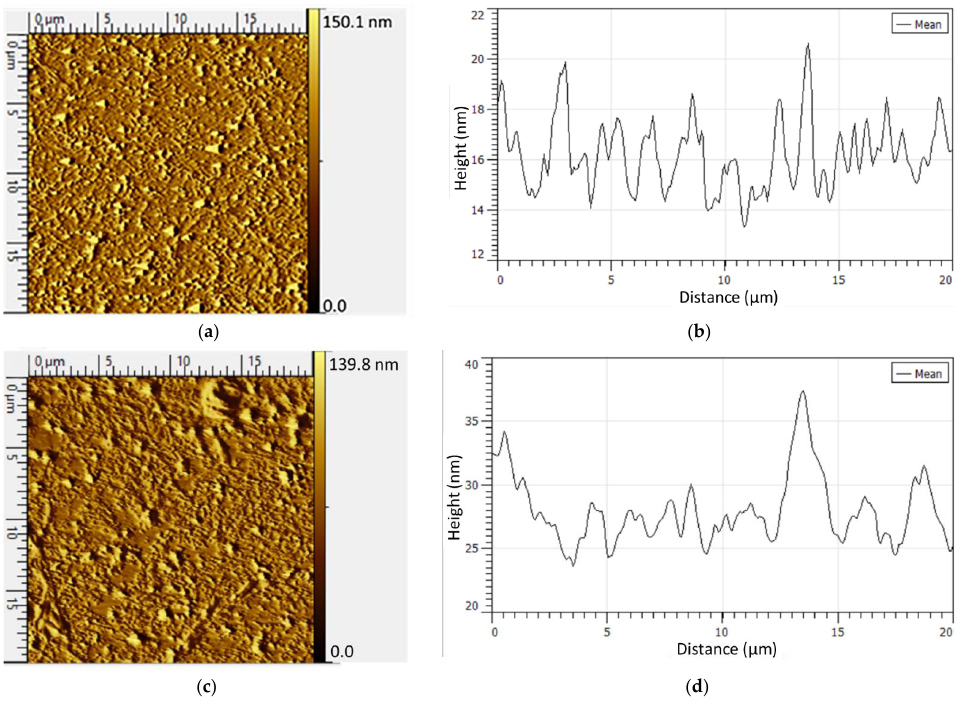
Figure 2. AFM images of ( a ) purified L – CNCs and ( c ) native L – CNCs; ( b ) Z-profile (height) of ( a ); ( d ) Z-profile of ( c ). Table 1. Size and zeta potential of purified L – CNCs and native L – CNCs.